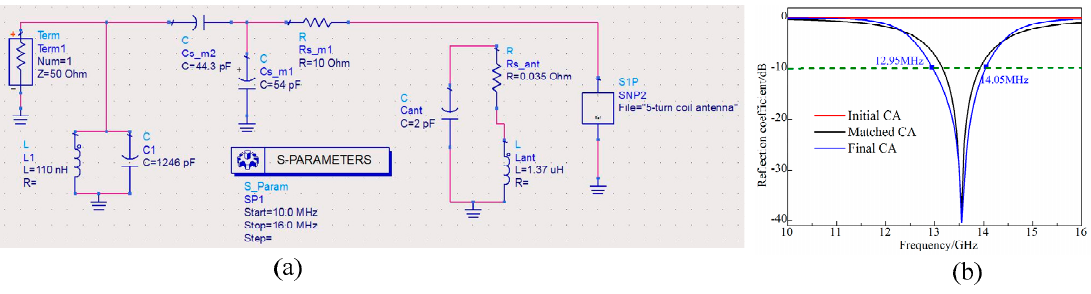
Figure 10. ( a ) The model of ultimate circuit; ( b ) S-parameters of all circuits in 3 steps.